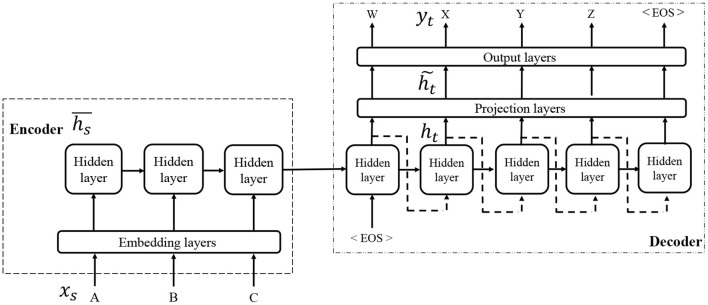
Overview of Seq2Seq.